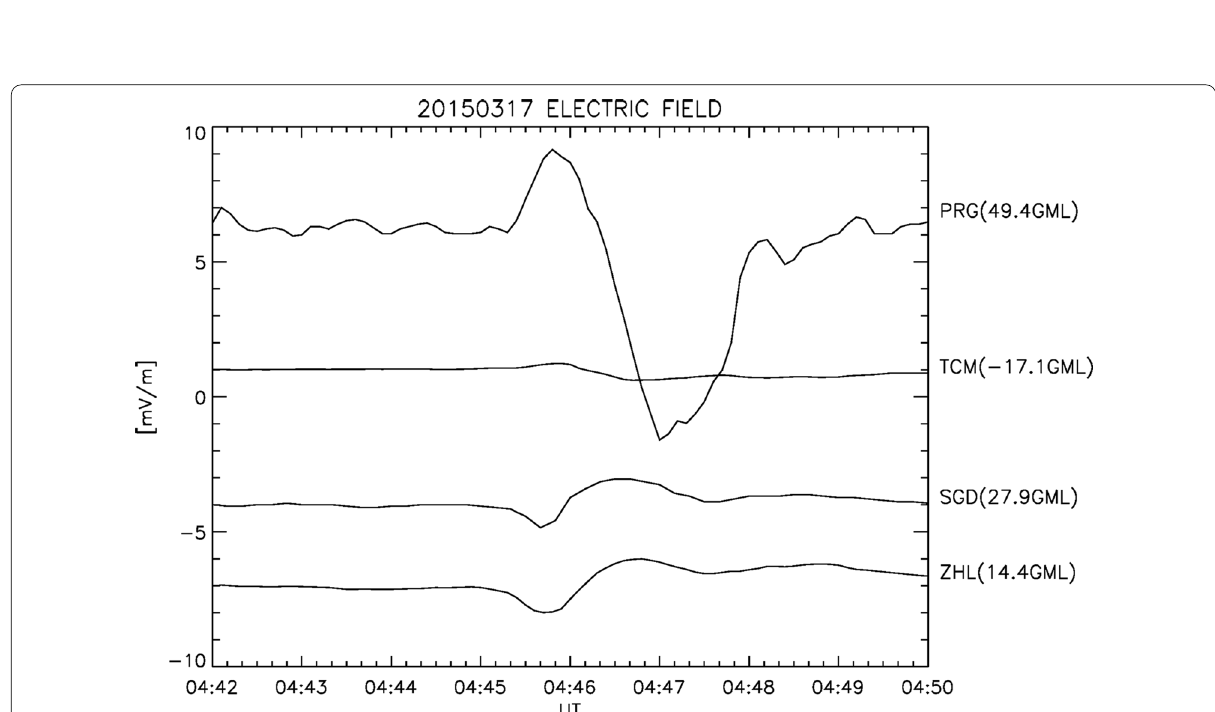
Fig. 3 Electric fields of the PI and MI of the SC converted from the HF Doppler frequencies observed at PRG (49.4º GML) and TCM (-17.1º GML) on the nightside, and at SGD (27.9º GML) and ZHL (14.4º GML) on the dayside. The local time features meet the dusk-to-dawn PI and dawn-to-dusk